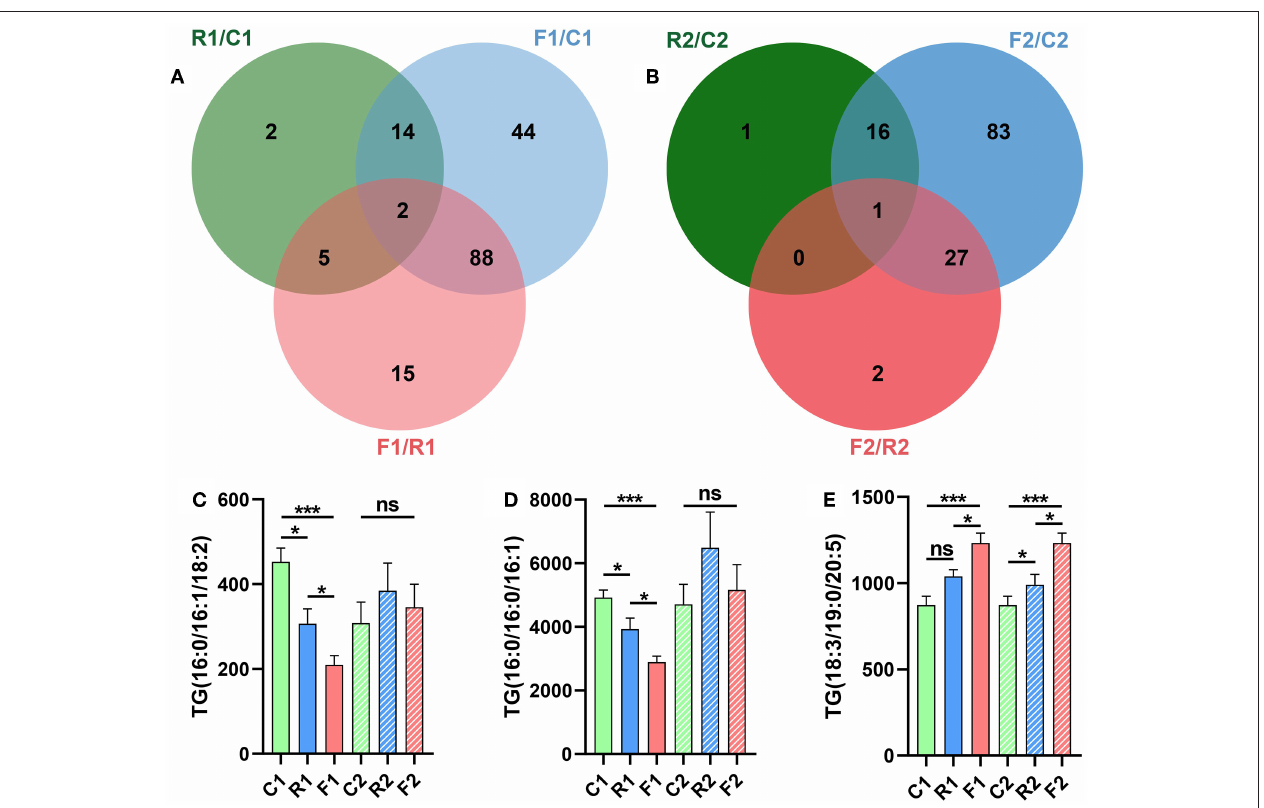
FIGURE 7 | Venn diagram showing that TGs are the key differential lipids. (A) Pairwise comparisons were made among the three groups at stage 1, and two of the three comparisons had identical differential lipids. (B) Pairwise comparisons were made among the three groups at stage 2, and one of the three comparisons showed identical differential lipids. (C) Column diagram of the differential lipid TG (16:0/16:0/18:2). (D) Column diagram of the differential lipid TG (16:0/16:0/16:1). (E) Column diagram of the differential lipid TG (18:3/19:0/20:5). * p < 0.05; *** P < 0.001; ns, not significant. n = 9–10 (R1 have 9 rats, C1, F1, C2, R2, and F2 have 10 rats). “ n ” means the number of samples/rats per group.